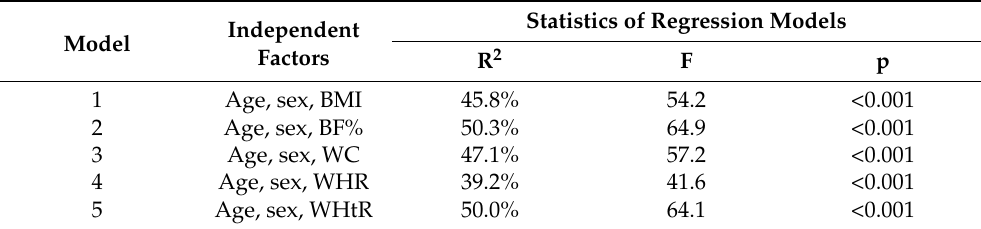
Table 4. Predictive values of the CRF test (number of laps) with reference to particular somatic indicators: the results of regression analysis.